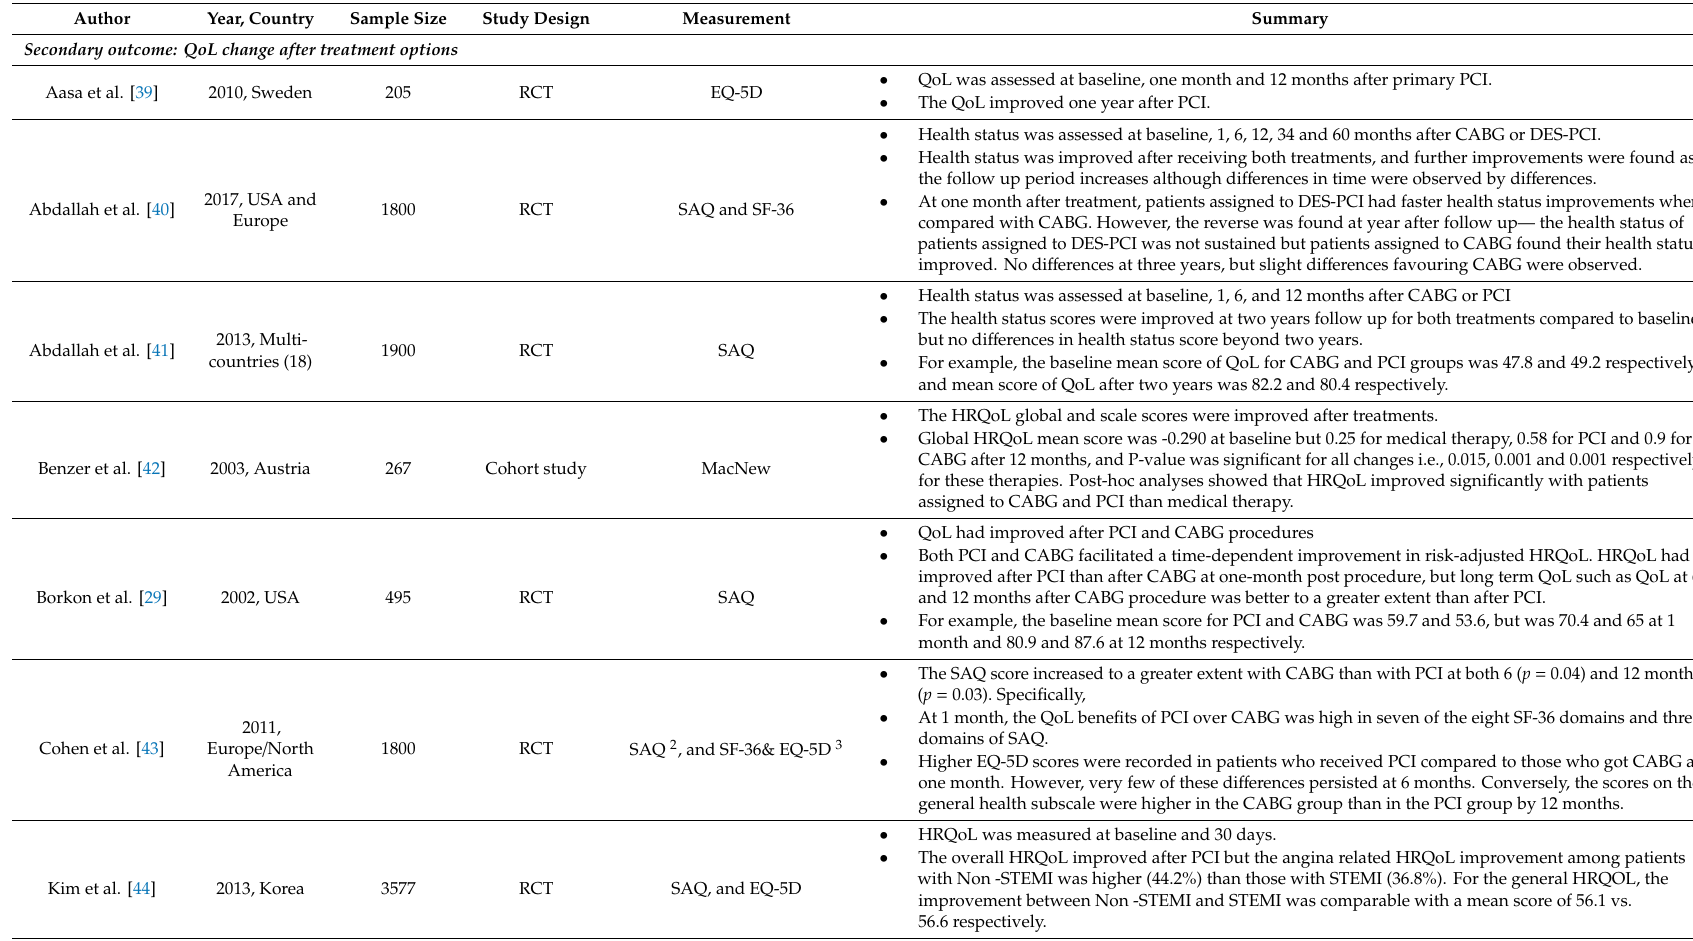
Table 1. Characteristics of included articles ( n = 29) 1